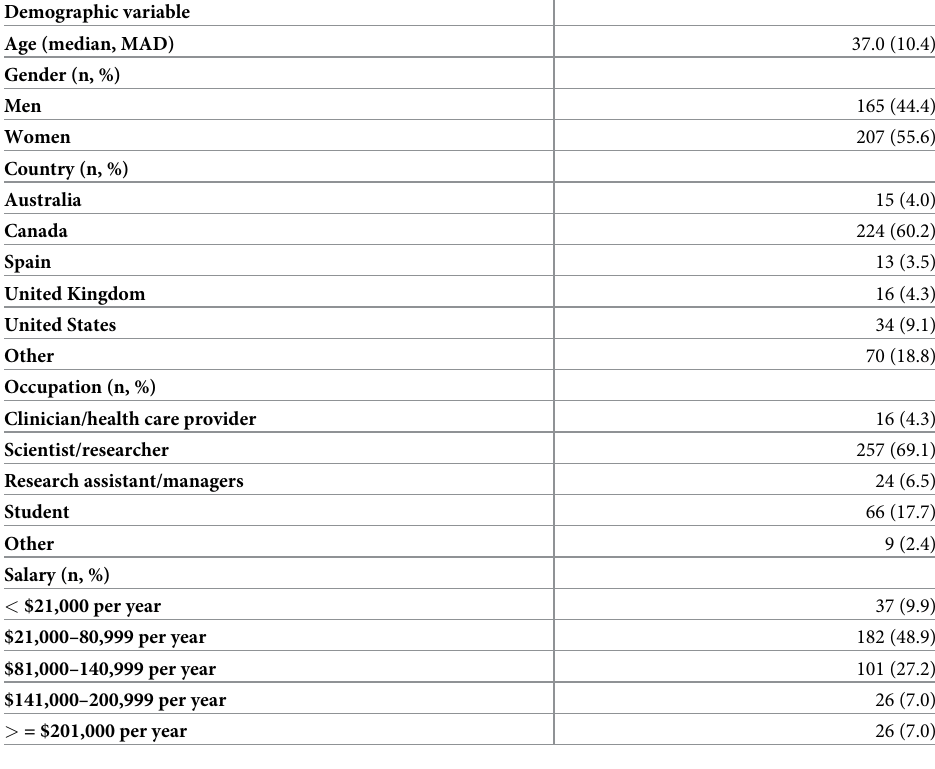
Table 1. Demographic information of participants (n =